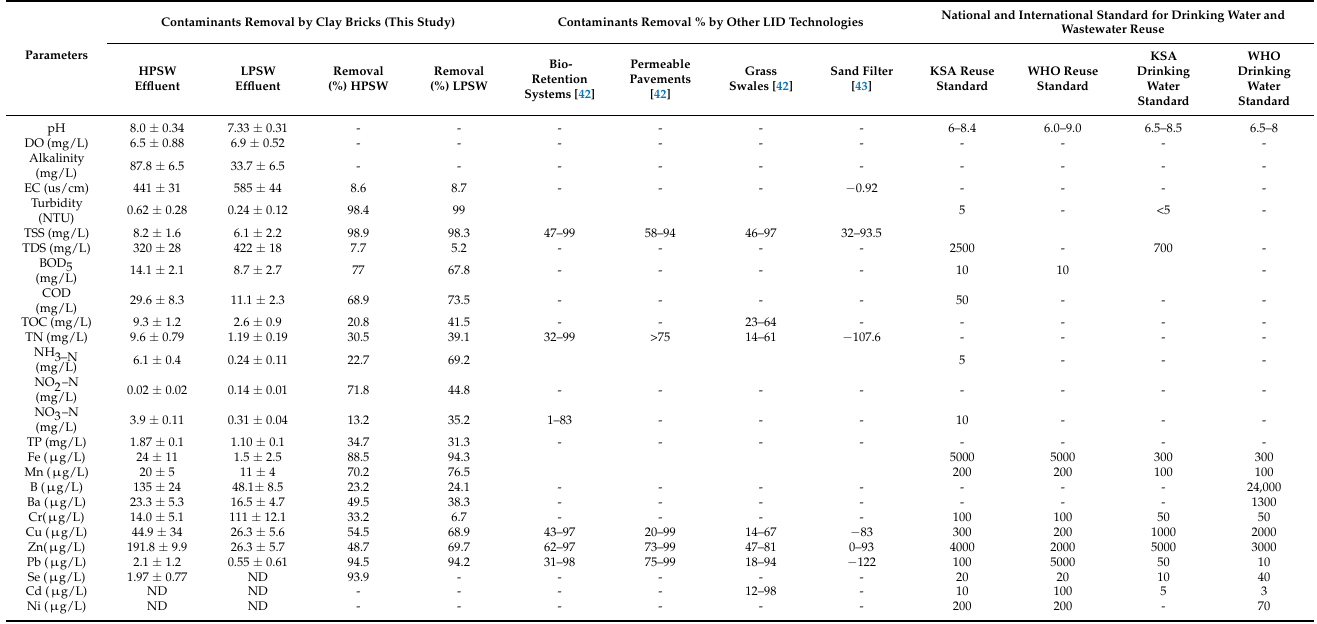
Table 4. SWs quality of two processes and standard limit for recycling and drinking